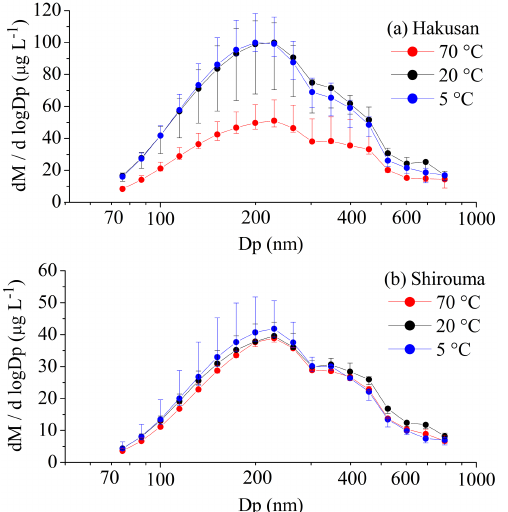
Figure 2. Mass size distribution of BC in (a) Hakusan and (b) Shi- rouma snow samples melted at 5, 20, and 70 ◦ C, where M and Dp denote the mass and diameter of a BC particle, respectively.